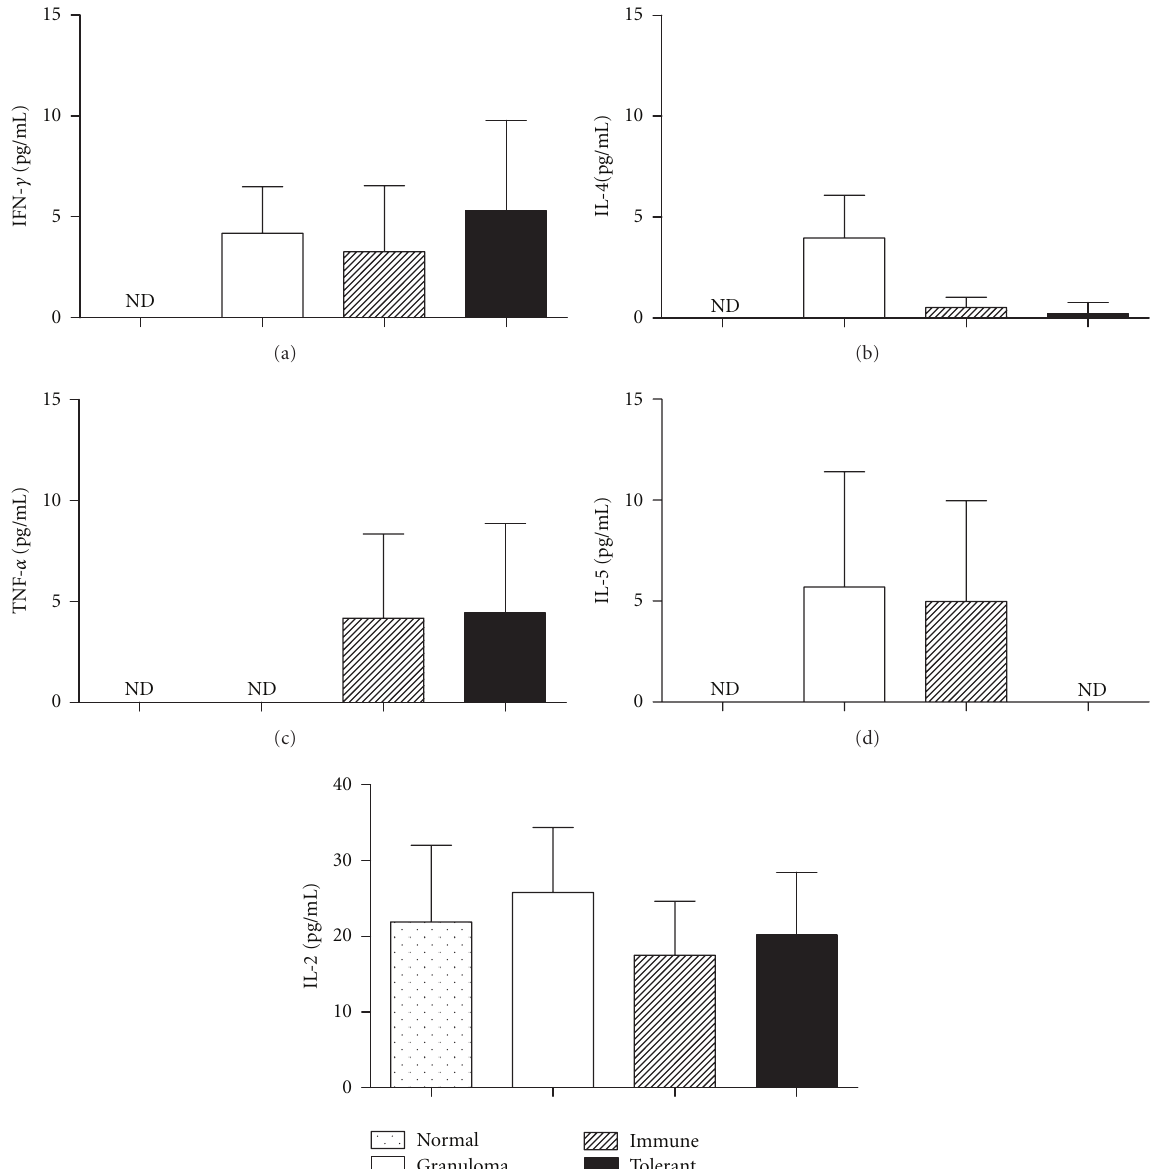
Figure 6: Cytokines production of lungs. Fourteen days after i.v. injection of S. mansoni eggs in nonimmunized mice (granuloma group, open bars), OVA immune controls (hatched bars), and OVA-orally tolerant mice (black bars), lungs were removed and homogenized in extract bu ff er. Normal mice (doted bars) were not immunized with OVA and neither injected with eggs. Extract supernatant was collected for cytokine assay. IFN- γ , TNF- α , IL-2, IL-4, and IL-5 were measured using a Cytometric Bead Array (CBA) kit. The results are shown as mean concentrations ± SEM. nd: not